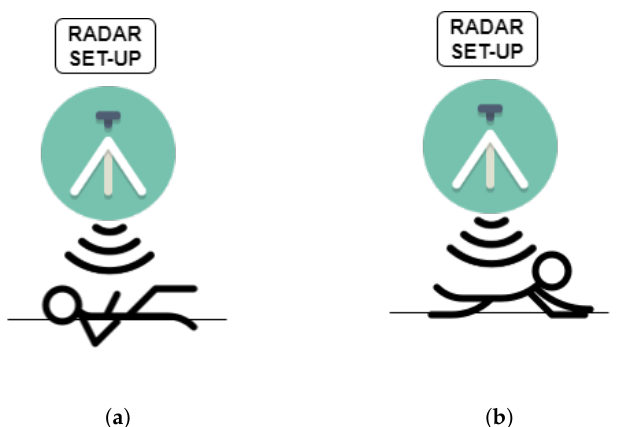
Figure 11. ( a ) Experimental scenario 1.1 diagram. ( b ) Experimental scenario 1.2 diagram.